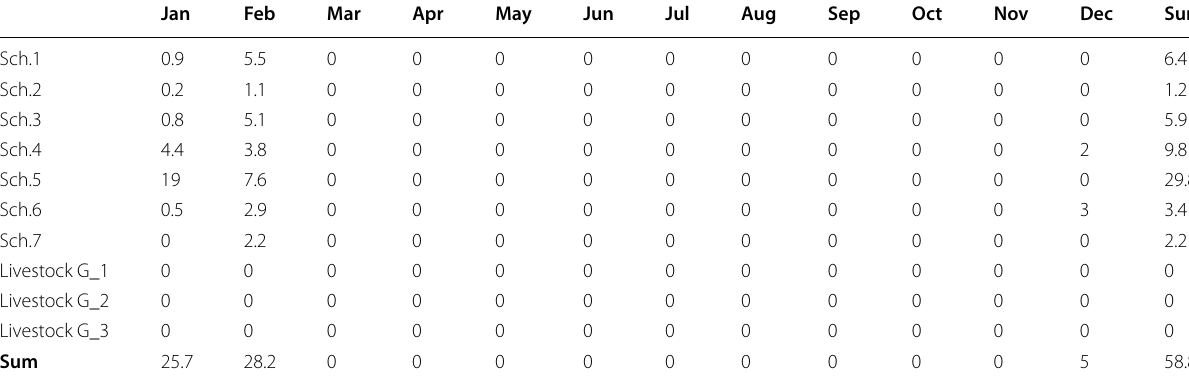
Table 12 Total unmet demand per scheme per month (‘000 m 3